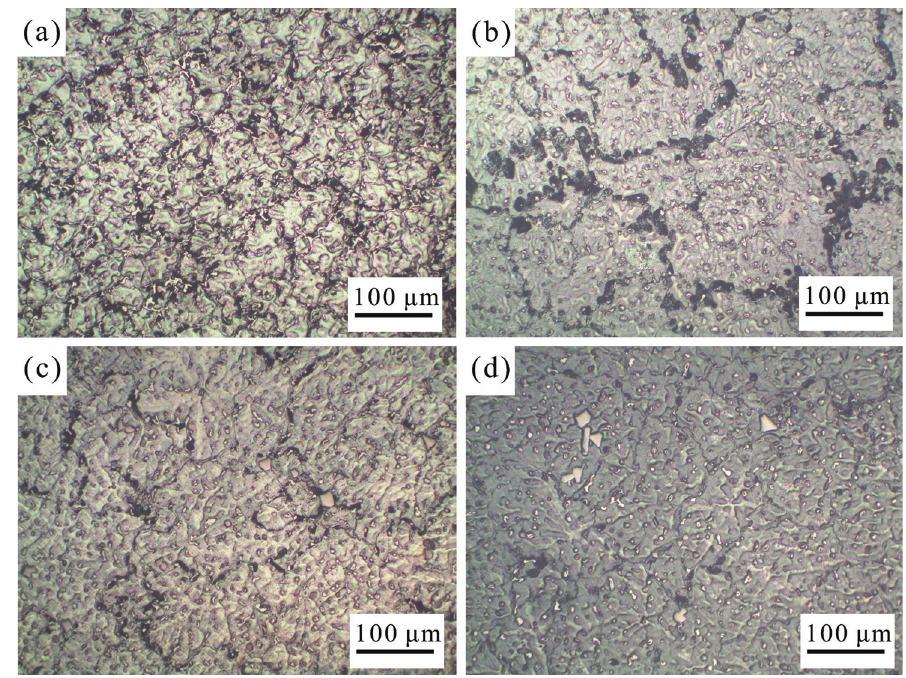
Figure 2: Metallographic structure of the as-cast AZ80 – 2Sn alloys with different Y additions: (a) alloy 1; (b) alloy 2; (c) alloy 3; (d) alloy